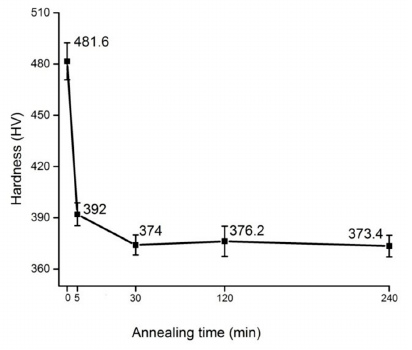
Figure 8. Vickers hardness values of the water-quenched and annealed samples; the hardness of the annealed samples remains stable even after 4 h annealing.